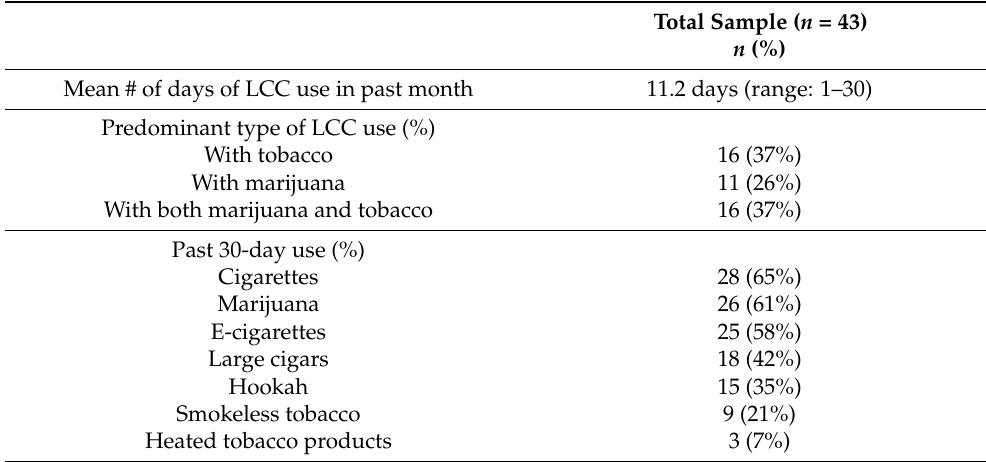
Total Sample ( n = 43) n (%)